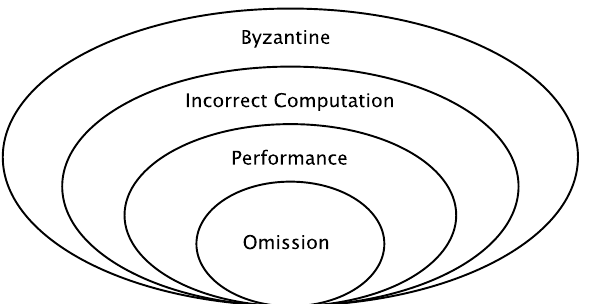
Figure 5. Inclusion hierarchy diagram that depicts the presented failure modes. Figure based on Figure 2.9 in